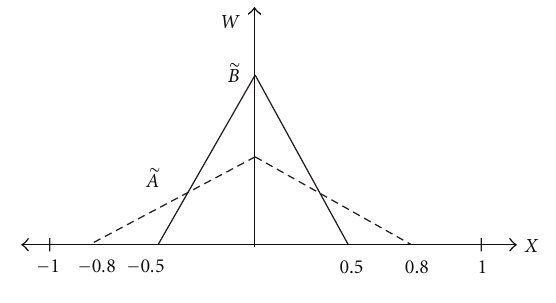
Figure 4: Two symmetric fuzzy numbers.